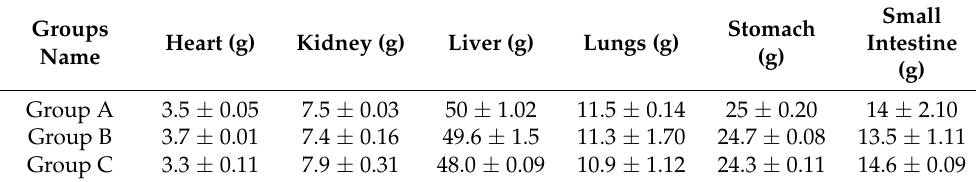
Table 6. Weight of organs from necropsied rabbits of all groups. (Mean ± SD, n = 5).